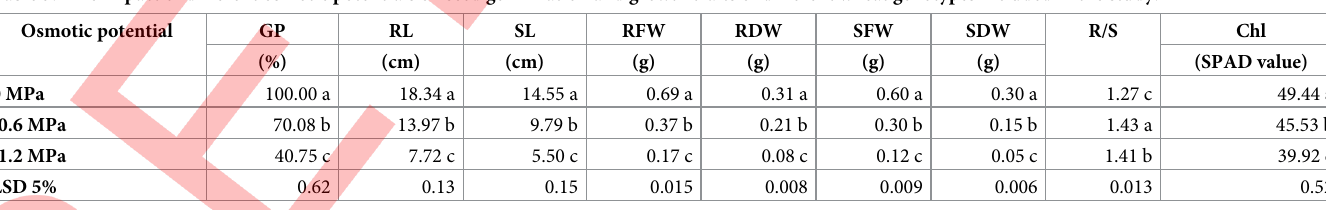
genotype ‘J4’. However, the lowest shoot length (8.34 cm) was recorded for the genotype ‘A12’, while the genotype ‘A12’ observed the lowest root fresh weight (0.35 g), shoot fresh weight (0.27 g), and shoot dry weight (0.10 g). Nonetheless, the lowest root dry weight (0.16 g) was recorded for the genotype ‘716’, whereas the genotype ‘Seher’ resulted in the lowest chlorophyll index (41.02 SPAD value) (Table 2). The highest values of seed germination percentage, root and shoot length, fresh and dry weights of roots and shoot, and chlorophyll index were recorded for control treatment, whereas the lowest values of these traits were noted for -1.2 MPa osmotic potential (Table 3). Contrastingly, the highest root:shoot ratio was noted for -0.6 MPa osmotic potential, whereas the lowest value was noted under control treatment of the study (Table 3). Regarding genotypes by drought stress interaction, all genotypes resulted in 100% seed ger- mination under control treatment; however, seed germination recorded a significant decrease. The genotype ‘J4’ with control treatment recorded the highest values for seed germination per- centage, root and shoot length, fresh and dry weights of roots and shoot, and chlorophyll index, whereas the lowest values for these traits were noted for the genotypes ‘716’ an ‘A12’ germinated under -1.2 MPa osmotic potential (Table 4). The genotypes ‘J4’ and ‘KTDH-16’ better tolerated increasing level of drought stress compared to the rest of the treatments included in the study, whereas genotypes ‘716’ and ‘A12’ proved as the most sensitive genotypes. Table 3. The impact of different osmotic potentials on seed germination and growth traits of different wheat genotypes included in the study. Osmotic potential